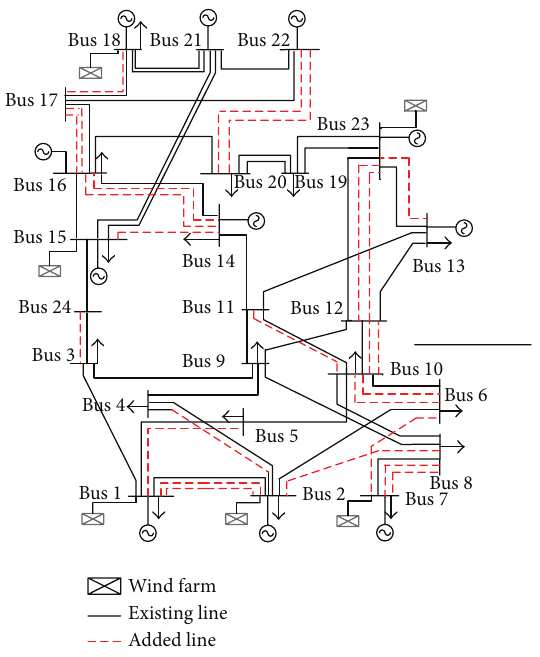
Figure 8: Final plan of Case 5.